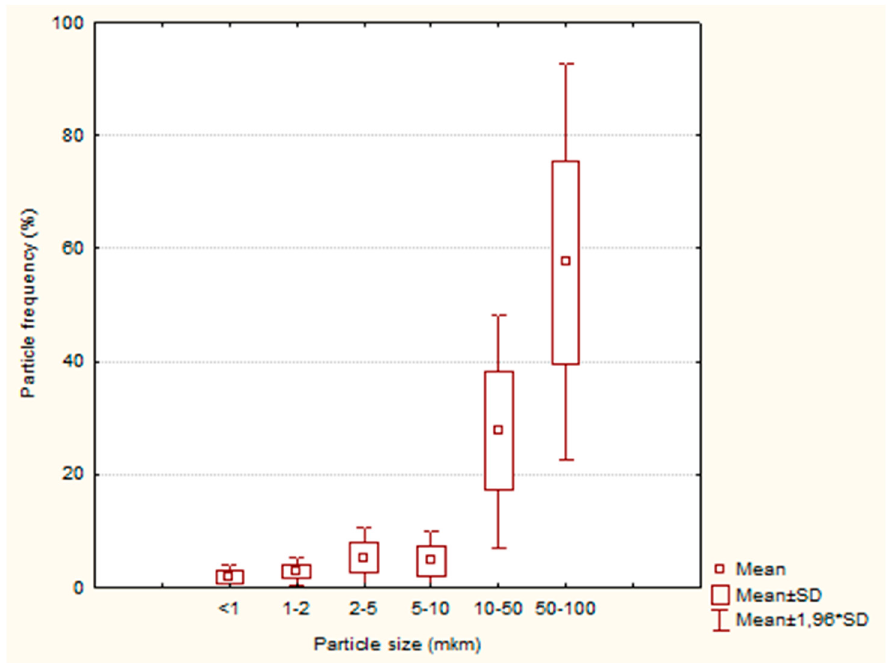
Figure 10. Box plot of particle size fraction in road dust in percent by volume.